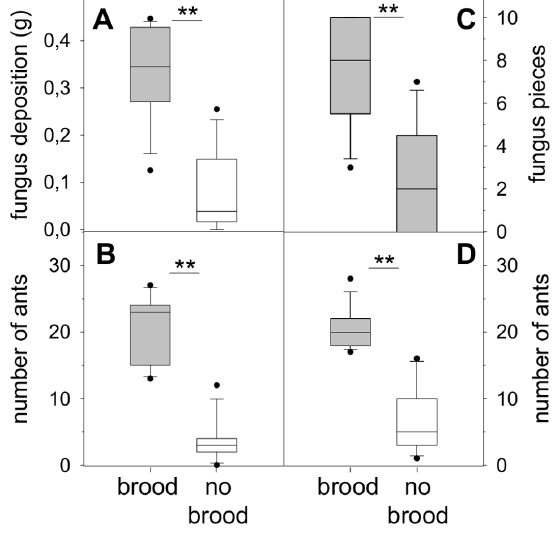
Figure 3. Fungus relocation experiment in non-digging setup. (a) Experiment 3: Fungus deposition in chambers, only one containing brood (n=12). (b) Number of A. lundi workers in chambers with and without brood (n=12). (c) Experiment 4: Fungus deposition at brood and empty side (n=13). (d) Number of workers at brood and empty side (n=13). Boxplots: median 6 25–75% percentiles, min max values and outliers, **p , 0.01.